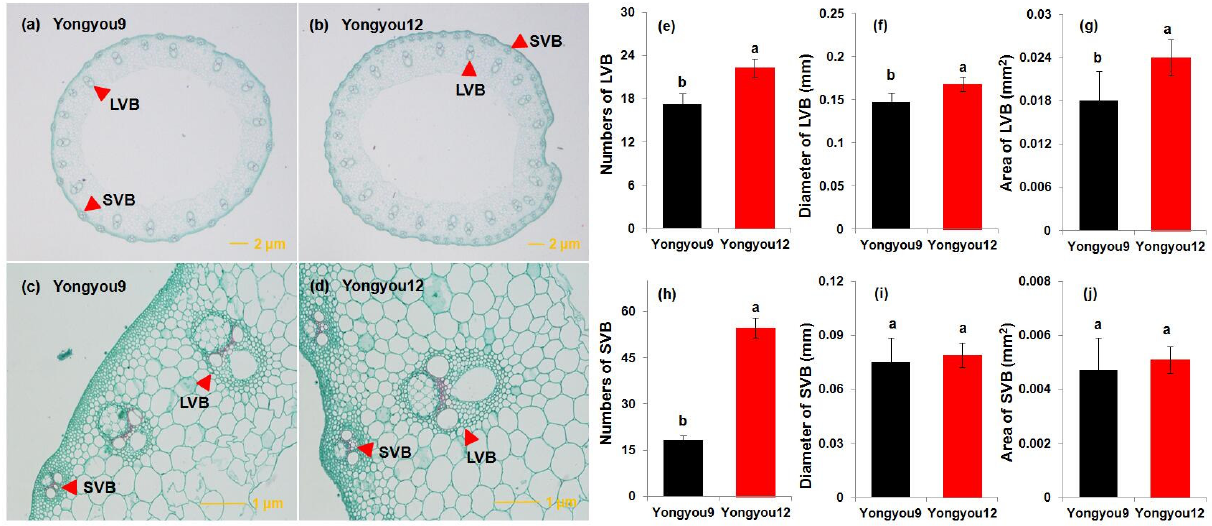
Figure 10. The numbers and size of vascular bundles in the panicle neck internodes of rice: ( a – d ) large vascular bundles (LVB) and small vascular bundles (SVB) inside the internode; ( e ) number of LVB; ( f ) diameter of LVB; ( g ) area of LVB; ( h ) number of SVB; ( i ) diameter of SVB; ( j ) area of SVB. Plant tissue sections were stained using 1% safranine and 0.5% fast green, and the dimensions (diameter and area) of the vascular bundles were analyzed with Image J software. Error bars denote ± standard deviation ( n = 10). Different letters indicate a significant difference at the 0.05 probability level.